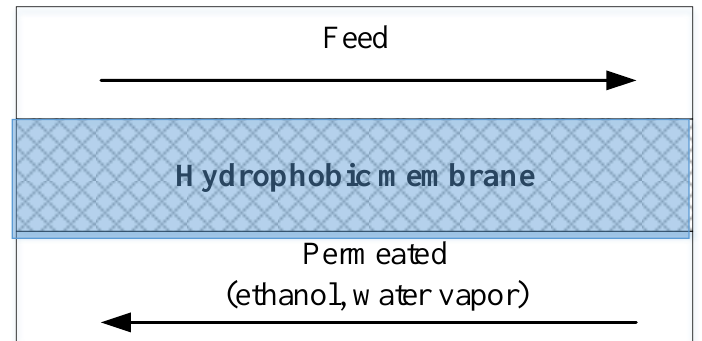
Figure 1. Schematic diagram of the membrane distillation process.